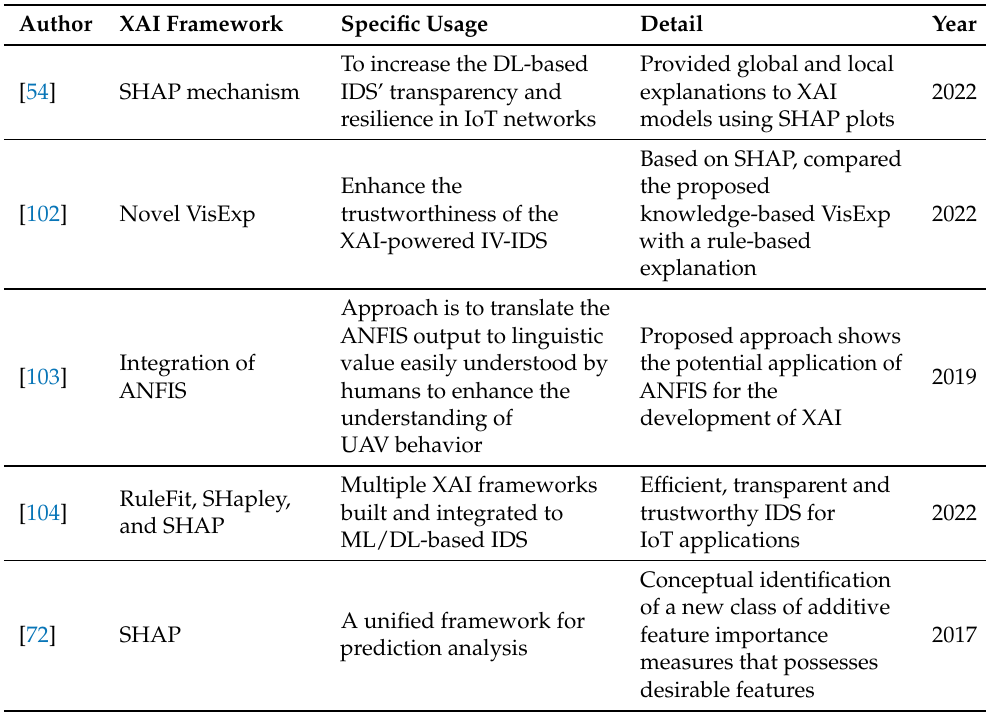
Table 4. Selected Publications Showing Usage of XAI